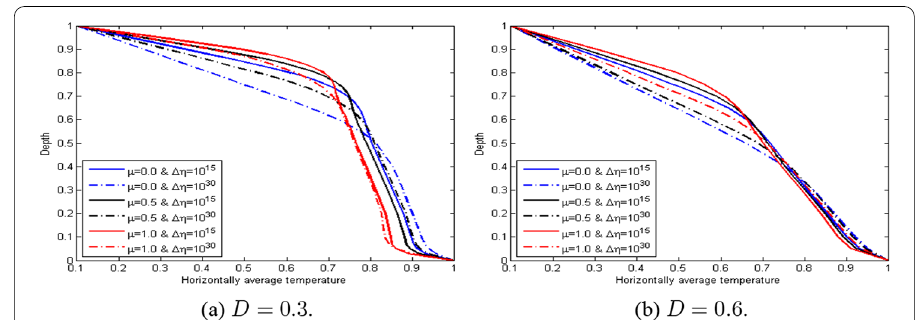
Fig. 7 Horizontally average temperature vs depth profiles at viscosity contrasts �η = 10 15 and �η = 10 30 for convection with µ = 0.0 , µ = 0.5 and µ = 1.0 at θ 0 = 0.1 and Ra = 10 7 with viscous dissipation D = 0.3 and D =